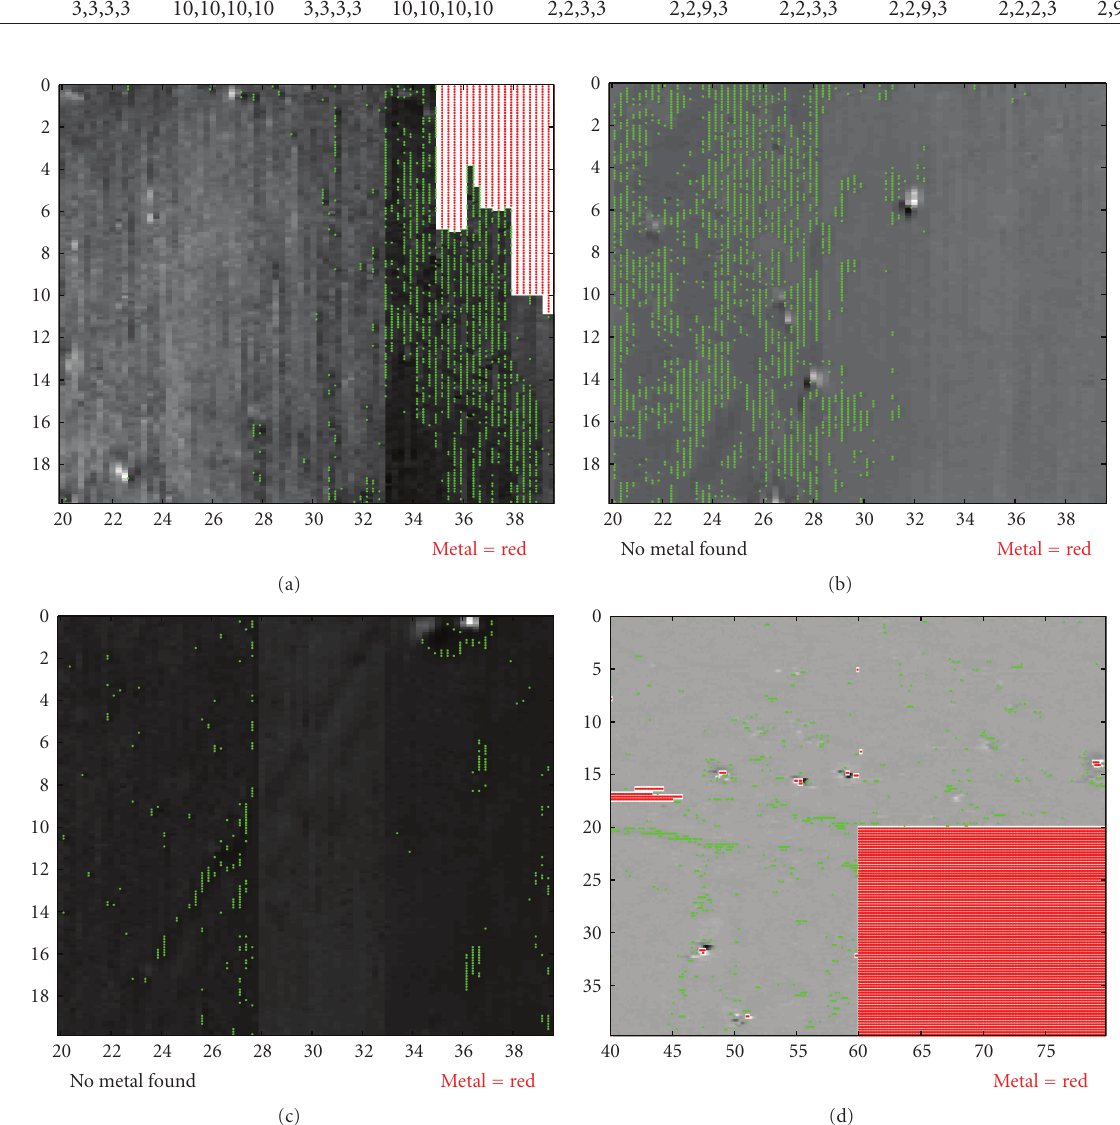
Figure 9: Data sets resulting from crisp cuto ff values [ − 5, − 3]. Subplots (a)–(d) represent di ff erent data files from di ff erent areas within the survey site (see Figure 1); (a) represents region A, (b) represents region B, (c) represents region C, and (d) represents regions D, E, and F (rotated 90 ◦ counterclockwise). Red pixels represent metallic objects and green pixels represent possible areas of